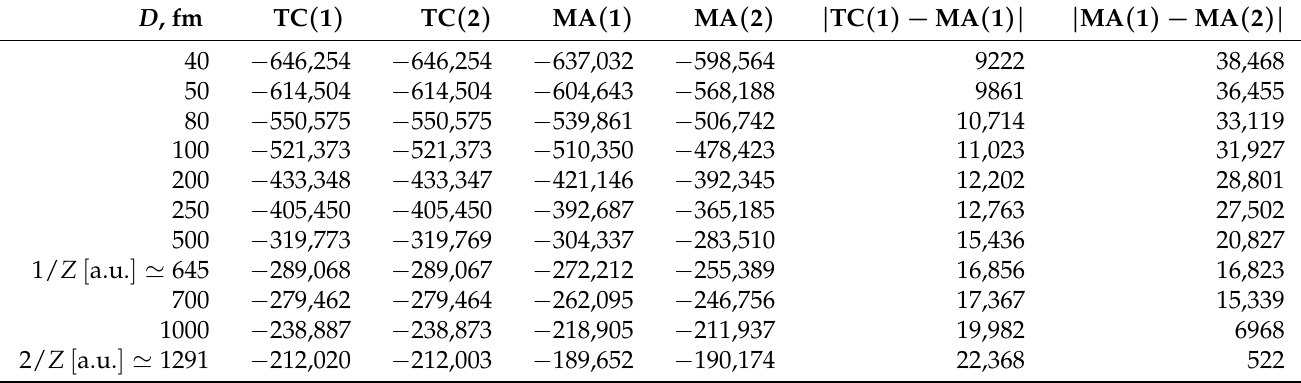
(in eV) of the Xe 54 + –Xe 54 + –e − quasimolecule. The notations are the same as in g